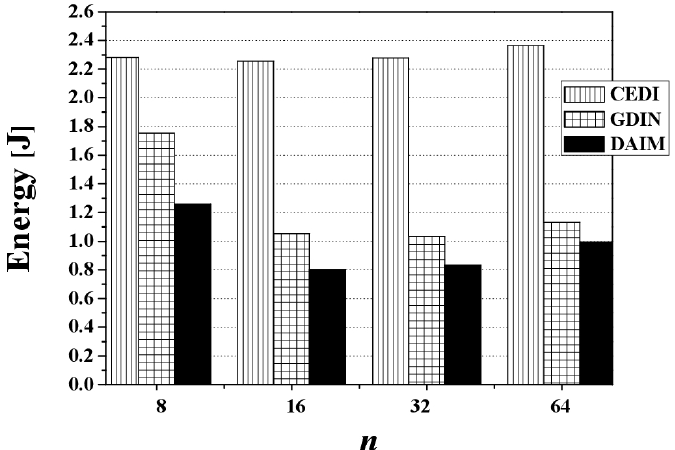
Figure 19. The comparison of the energy consumption over various n .